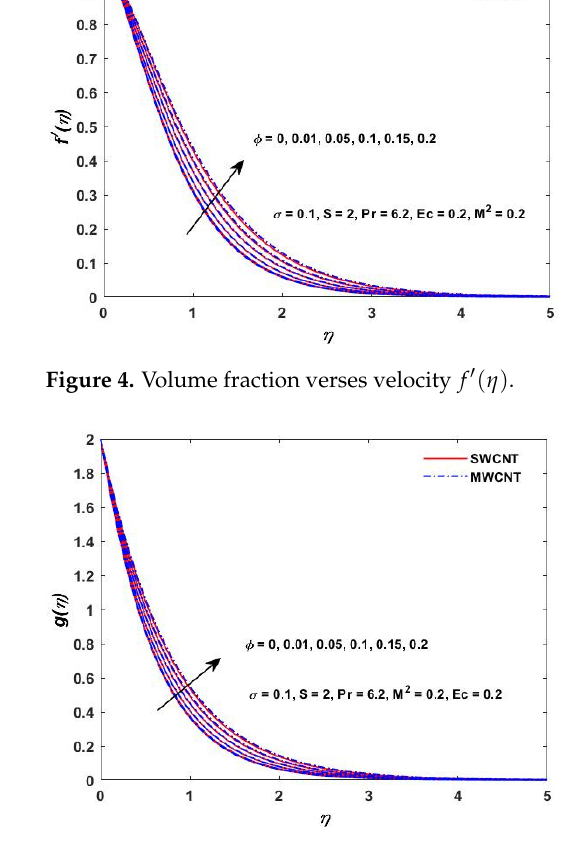
Figure 6. Rotation S verses velocity 𝑓 (cid:4593) (𝜂).